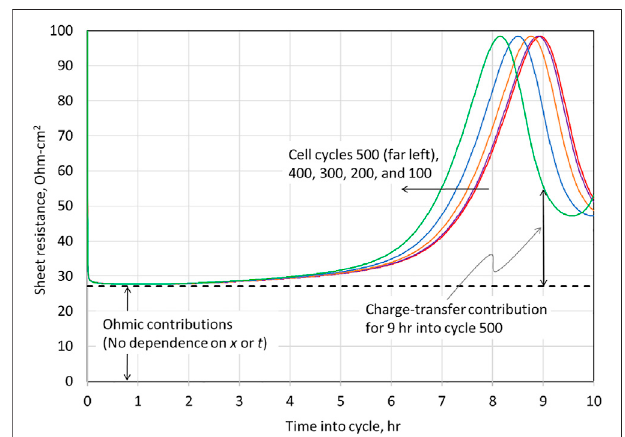
FIGURE 10 | Calculated open-circuit potential vs. the fractional occupancy of Li in the Li layer for various cycles. A blow-up of the potential at the end of de-lithiation is shown in the upper right inset plot.